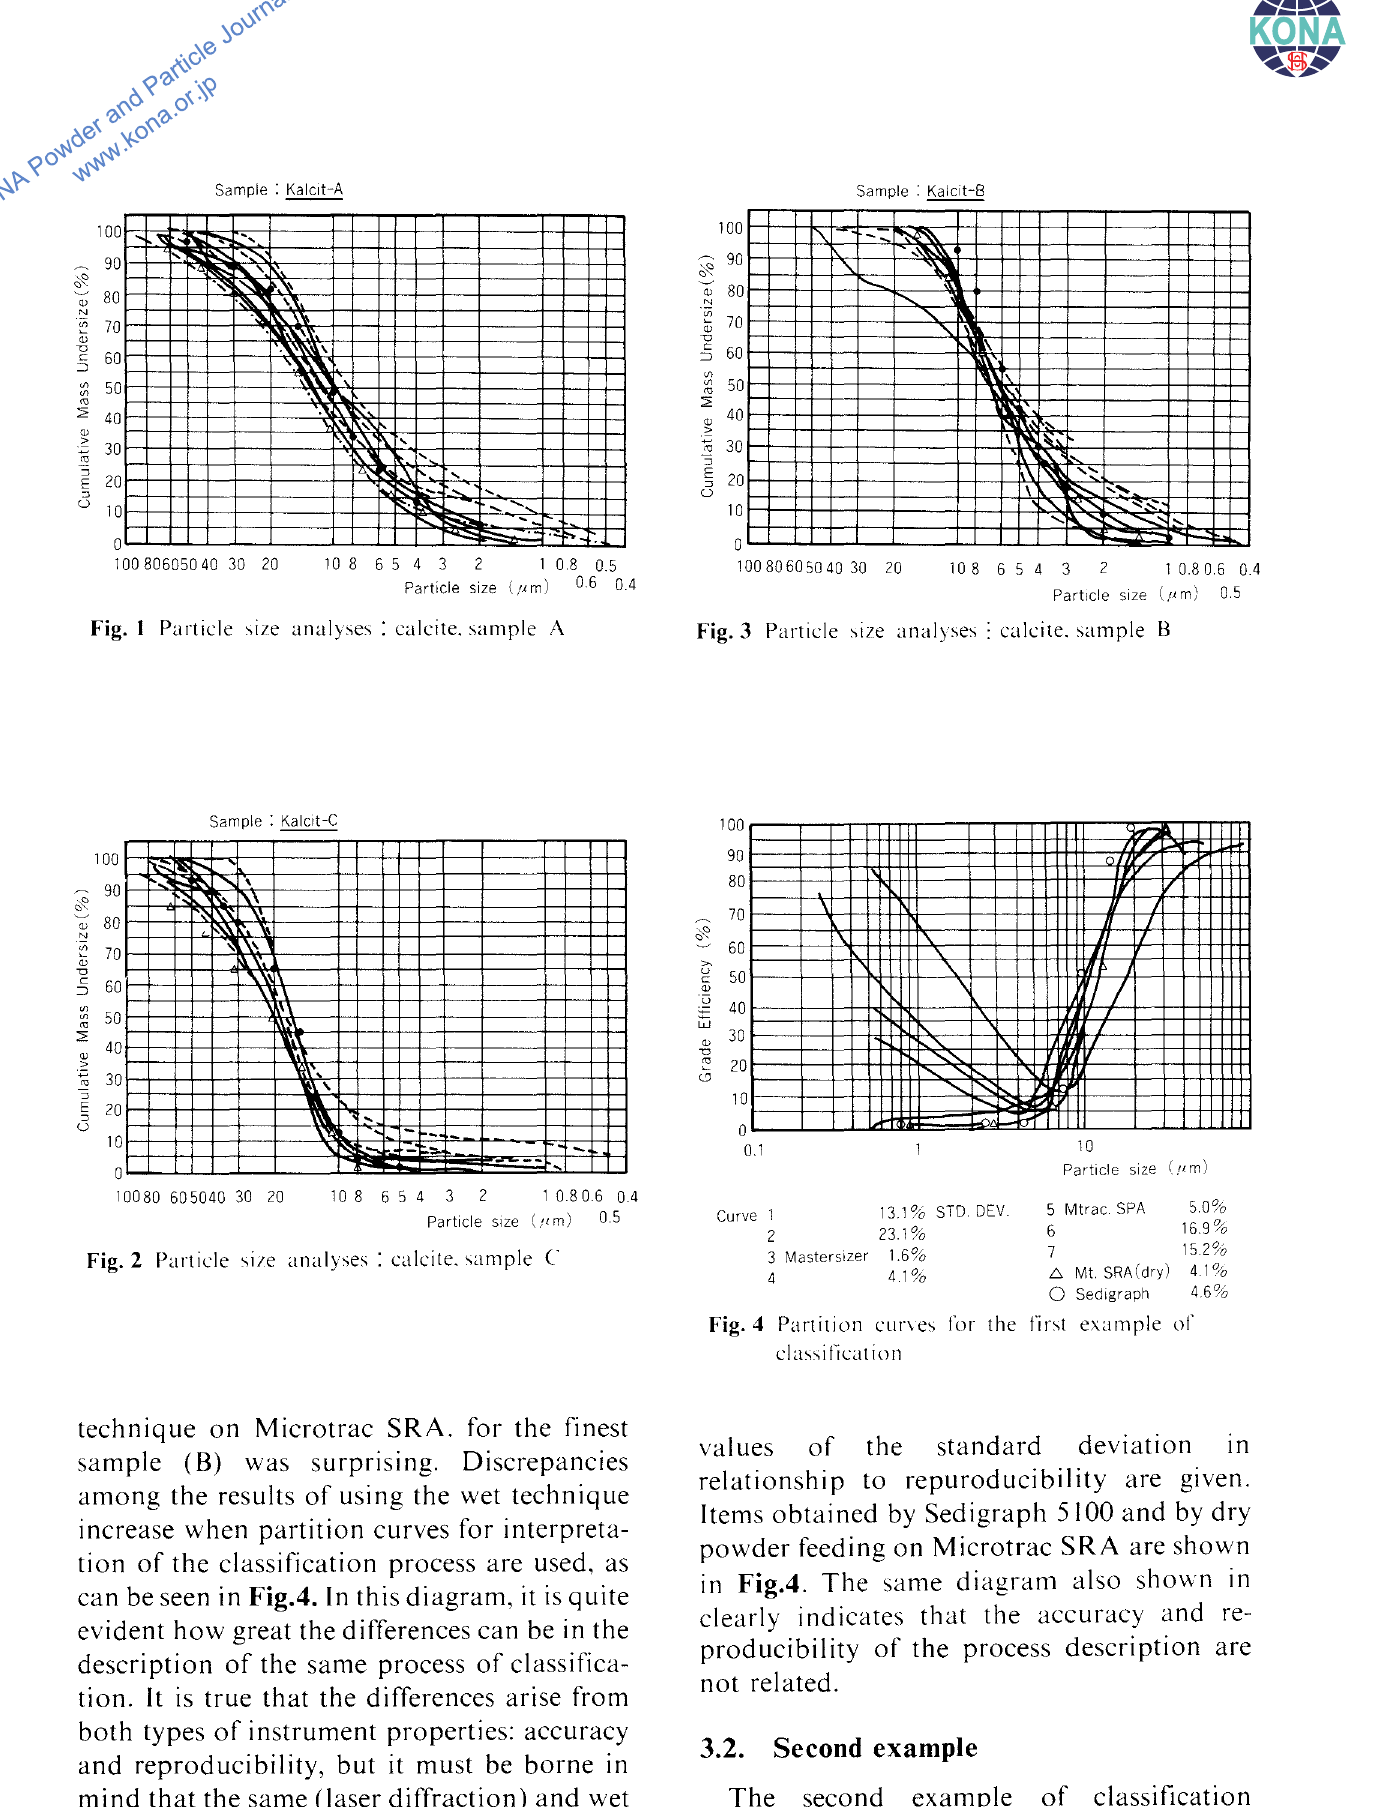
Fig. 2 Particle si1e analyses : calcite. 'ample C technique on Microtrac SRA. for the finest sample (B) was surprising.